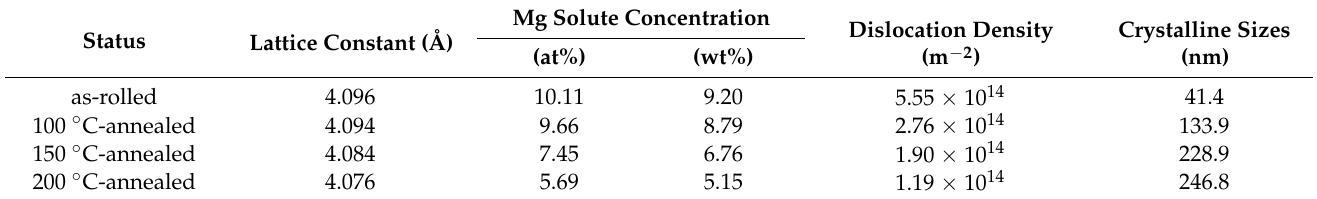
Table 1. Lattice constant, Mg solute concentration and dislocation density of as-rolled and